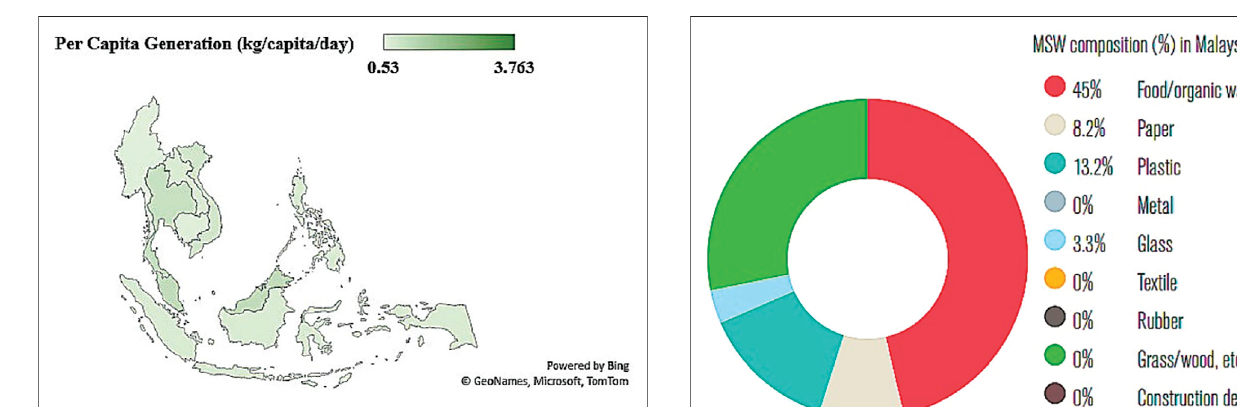
FIGURE 1 | The ASEAN countries waste amount generation per capita as per the fourth ASEAN State of Environment Report 2009.